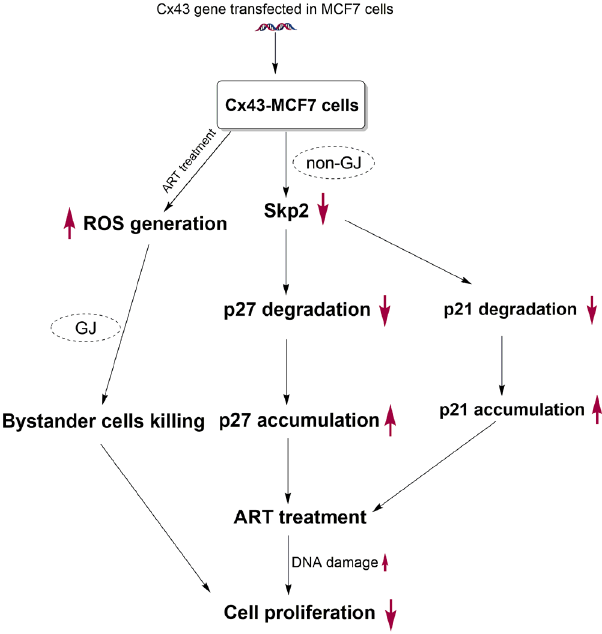
Figure 7. Schematic for the role of Cx43 in enhancing GJ dependent as well as GJ independent cytotoxicity of